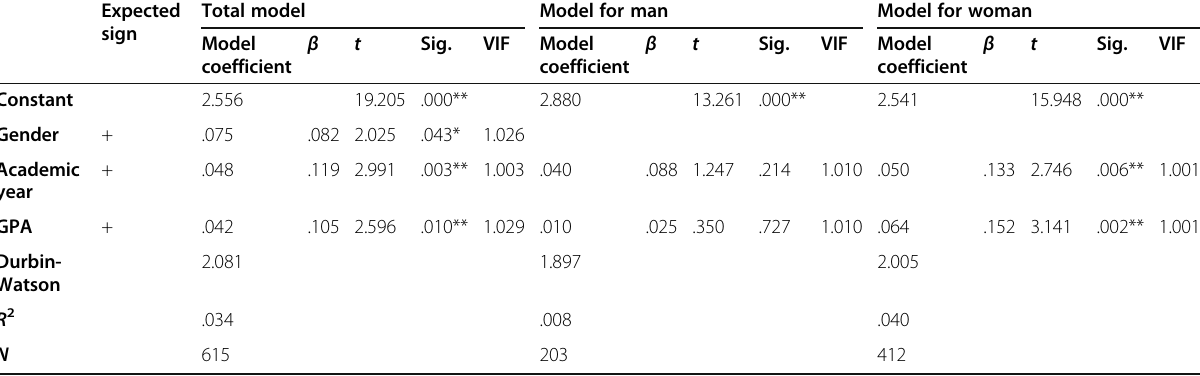
Table 6 Multiple linear regression models for the total sample, for men and for women Expected